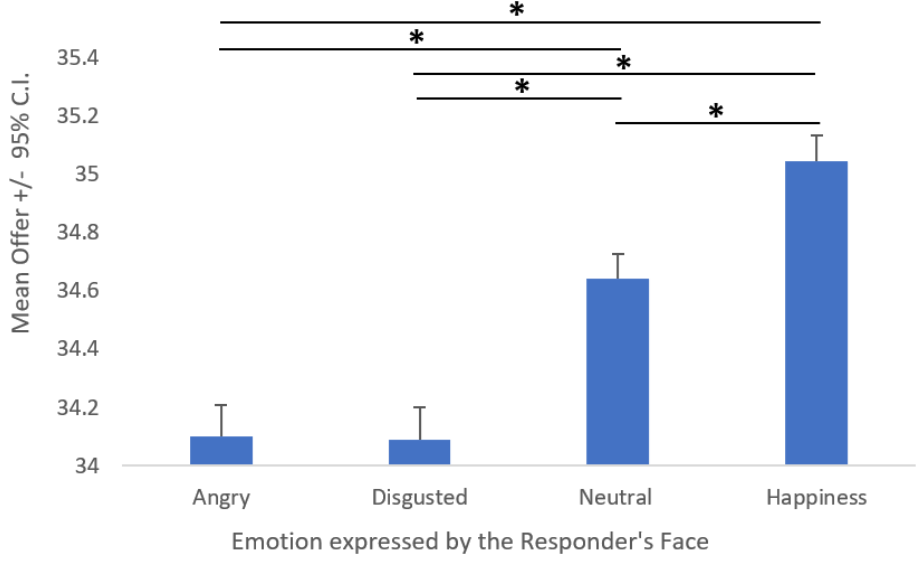
Figure 5. Main effect of the emotion expressed by the responder’s face on the proposer’s average offer. Asterisks (*) indicate significant post hoc comparisons.